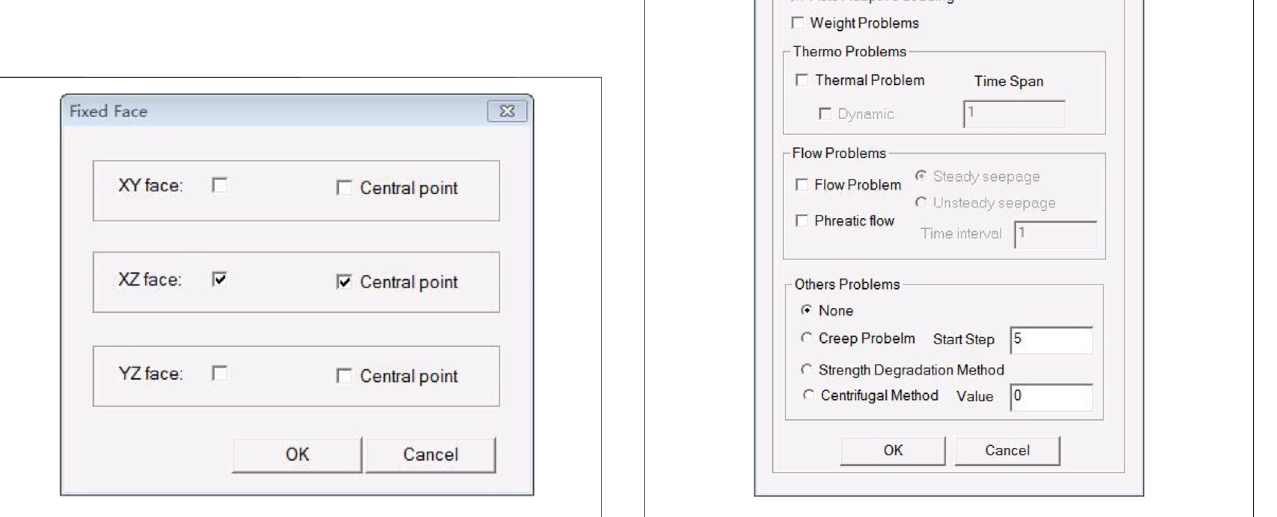
FIGURE 6 | Numerical calculation of control conditions. FIGURE 4 | Constraints at the bottom of the rock specimen model.